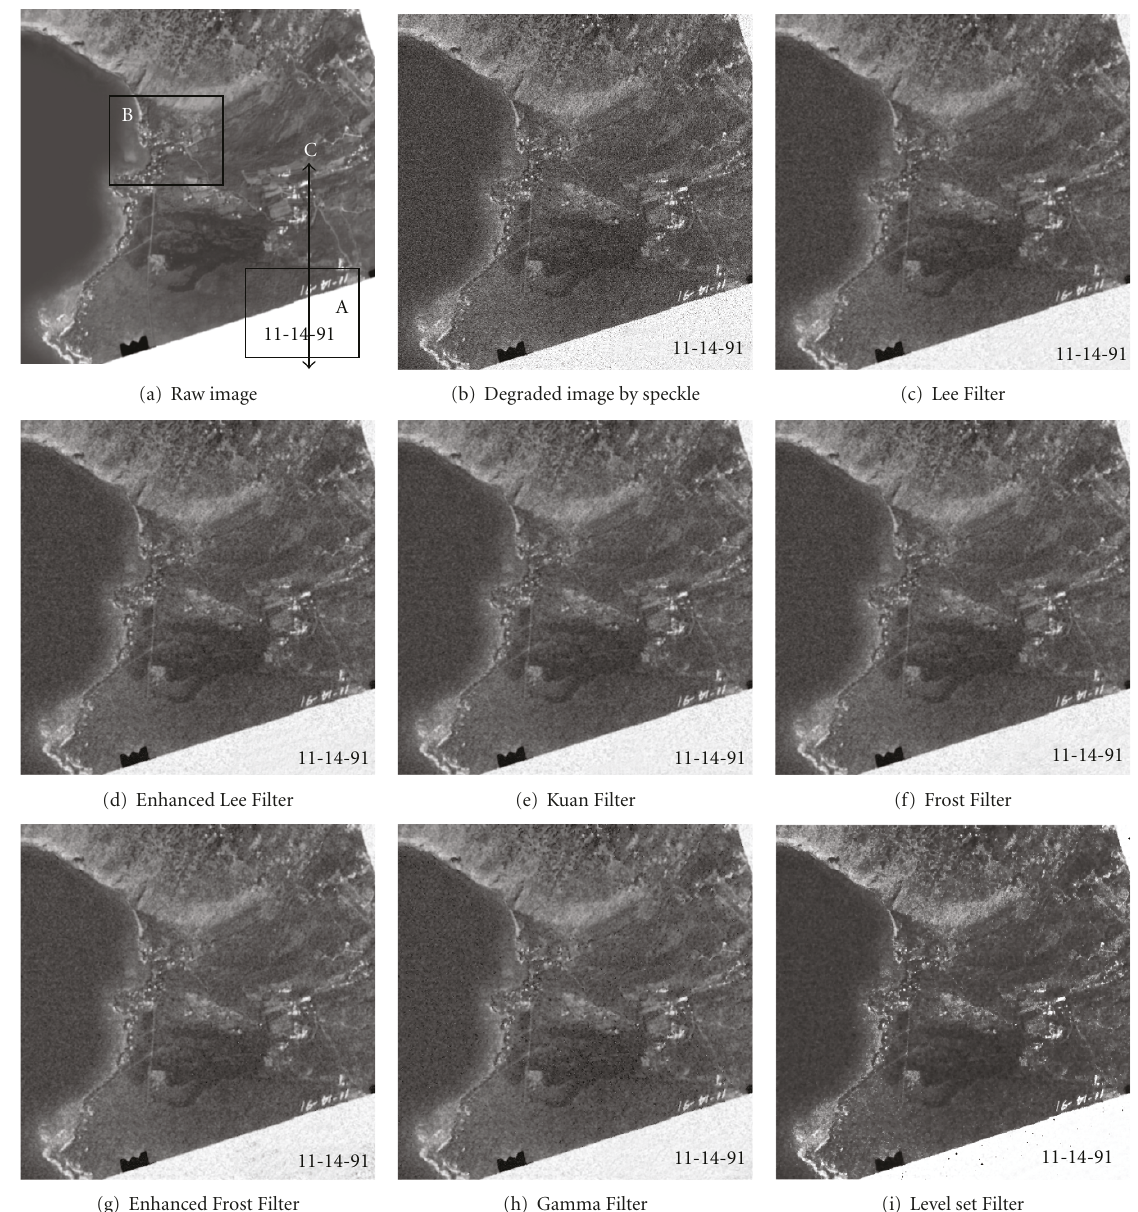
Figure 2: The proposed level set-based filter in contrast to the conventional approaches of simulation